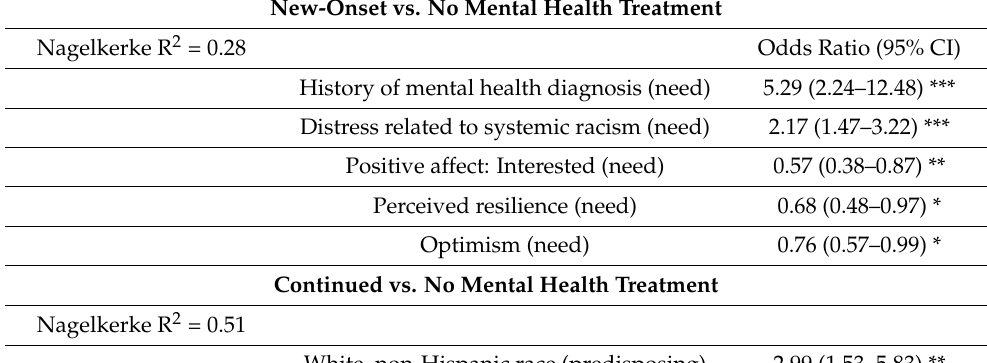
Table 1. Predictors of mental health treatment among COVID-19 frontline health care workers. New-Onset vs. No Mental Health Treatment Nagelkerke R 2 =